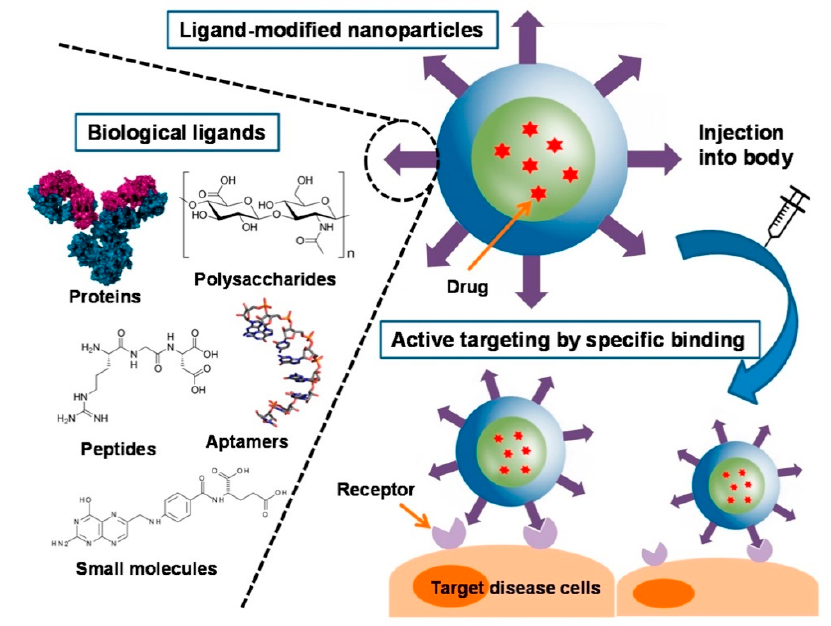
Figure 5. Schematic illustration of biological ligands used for active targeting in nanoparticles. Adapted from (Cancers. 2019, 11, E640. Multidisciplinary Digital Publishing Institute).